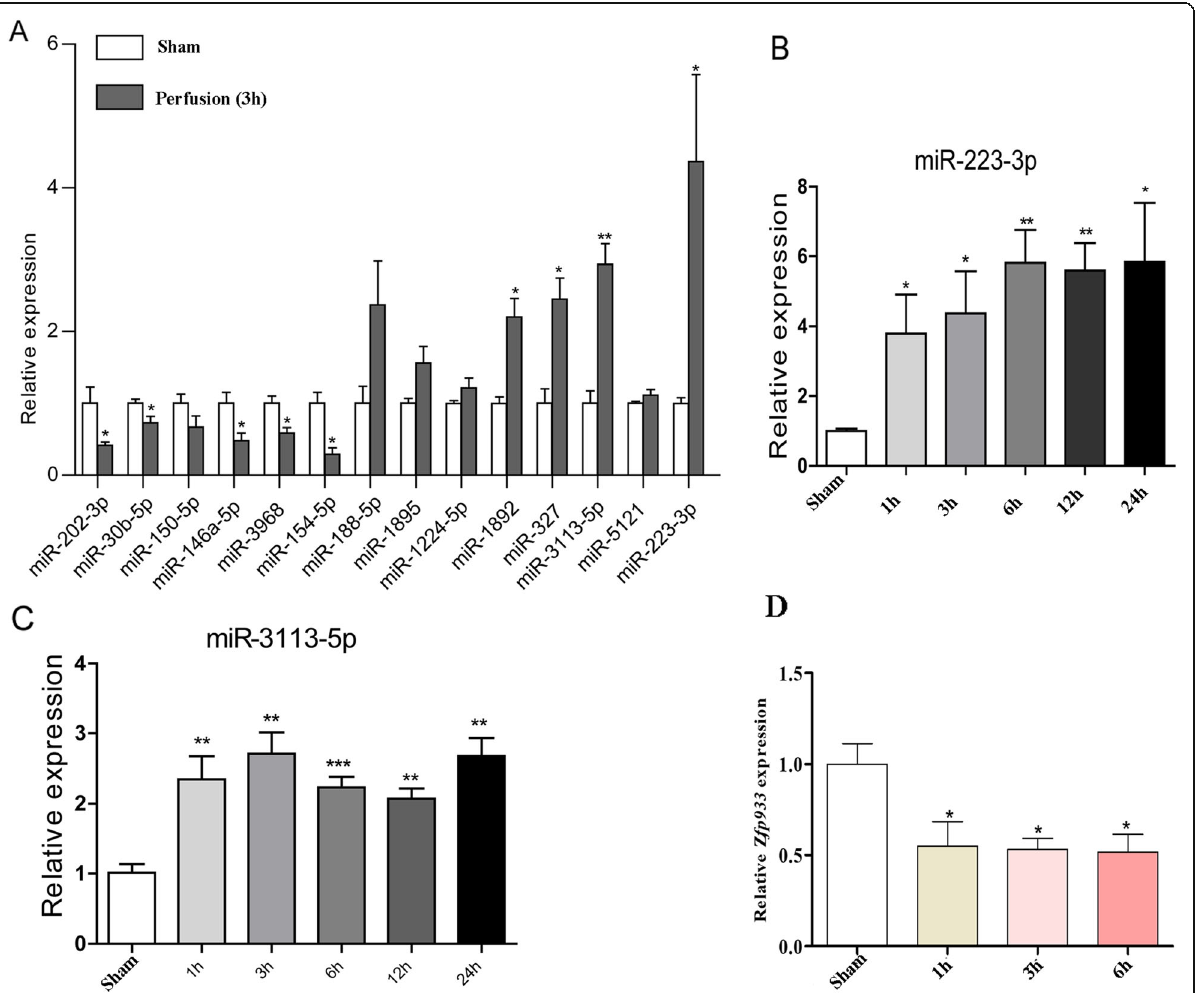
Fig. 4 RT-qPCR validation of the differentially expressed microRNAs. a RT-qPCR analysis of all the 14 potential microRNAs in heart tissues. b-c RT- qPCR analysis of microRNA 223-3p and microRNA 3113-5p in heart tissues with distinct perfusion time. d RT-qPCR analysis of cardiac Zfp933 expression (a predicted microRNA 3113-5p target gene) in heart tissues with distinct perfusion time. *, p < 0.05; **, p < 0.01 vs.